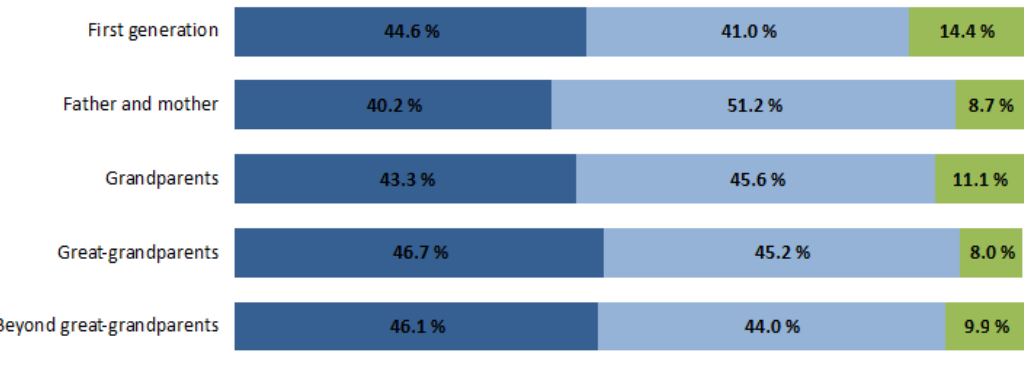
Figure 7. Tsunami risk perception according to the number of generations of residence in the